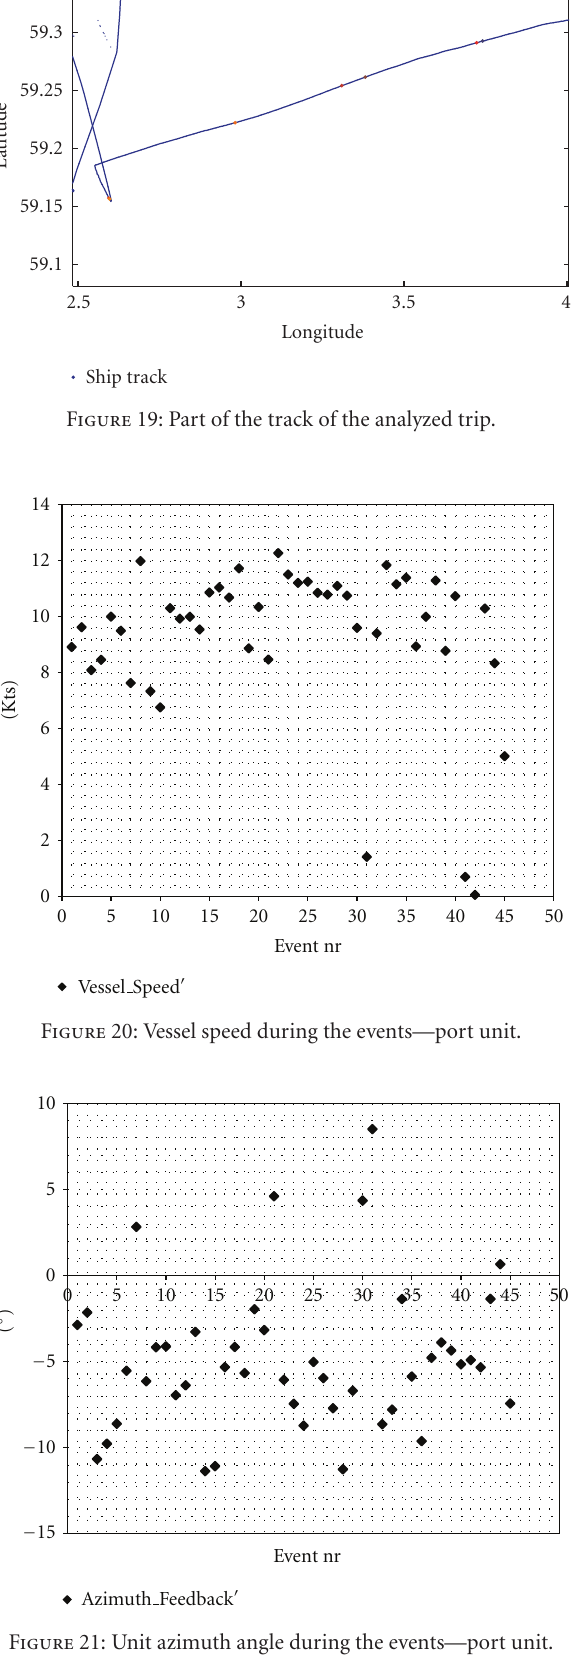
Figure 21: Unit azimuth angle during the events—port unit.